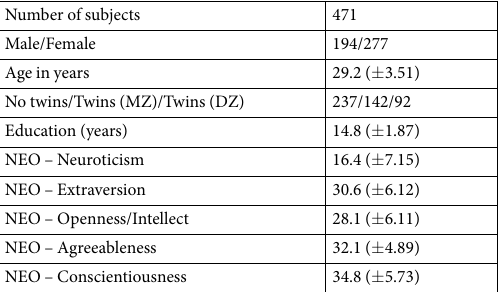
Table 1. Demographics and personality factors. Personality traits and demographics of the included